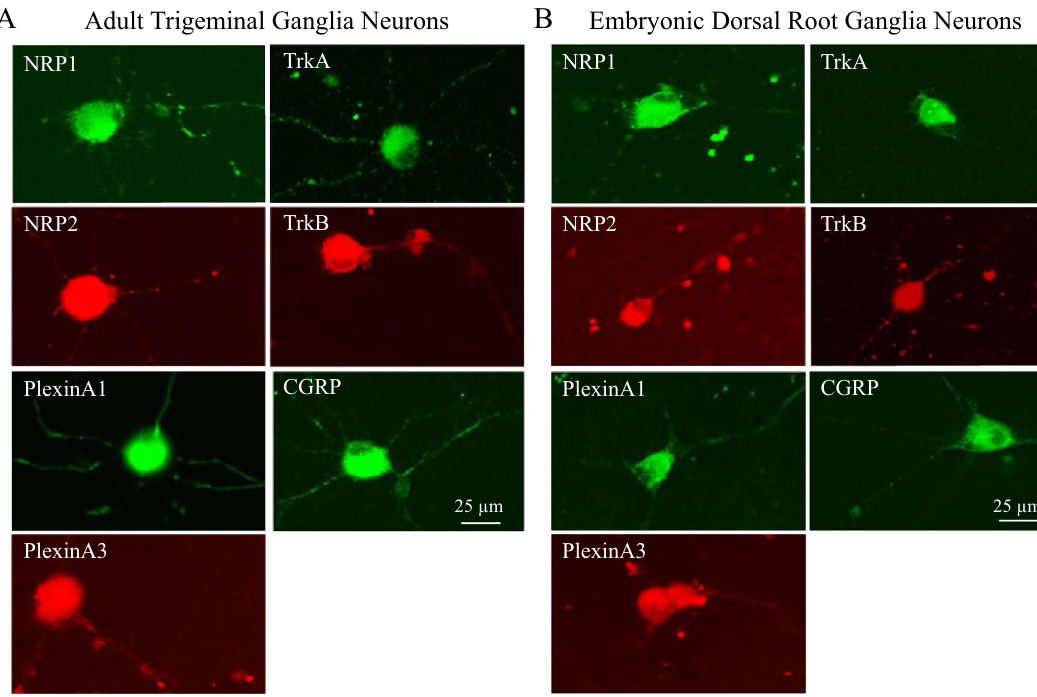
Figure 5. Expression of Sema3A, NGF and BNDF receptors in adult TG and embryonic DRG neurons. The expression of Sema3A receptors (NRP1, NRP2, PlexinA1 and PlexinA3) and the NGF receptors TrkA, the BDNF receptor TrkB, and the neuropeptide CGRP in isolated TG and DRG neurons was evaluated by immunofluorescence staining. Representative images of TG neurons treated with Sema3A ( A ) show expression of all receptors both in the cell body as well as in the growing neurites. We found that 100% of neurons express the receptors and the neuropeptide CGRP. Similarly, all of these receptors were also expressed in DRG neurons treated with NGF ( B ). However, 100% of the neurons expressed NRP1, NRP2, PlexinA3, TrkA and CGRP, while 75% of the DRG neurons expressed PlexinA3 and TrkB. In general, there were no major differences in Sema3A receptor expression between the adult and embryonic sensory neurons. Additionally, no differences were observed in the expression of the neuropeptide CGRP. See Table 1 in “Materials and methods” for antibody information. All images were taken at same magnification, scale bar = 25 μm. The background effect generated by the secondary antibody (staining without primary antibody) is shown on Supplementary Fig.